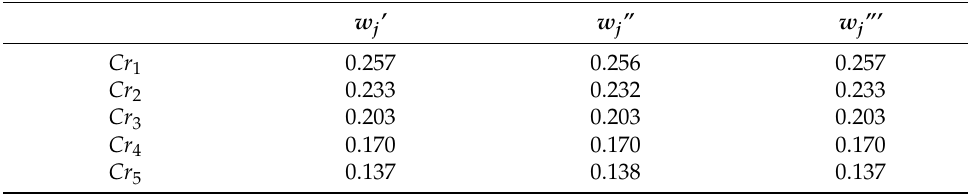
Table 6. The criteria weight obtained using three approaches.